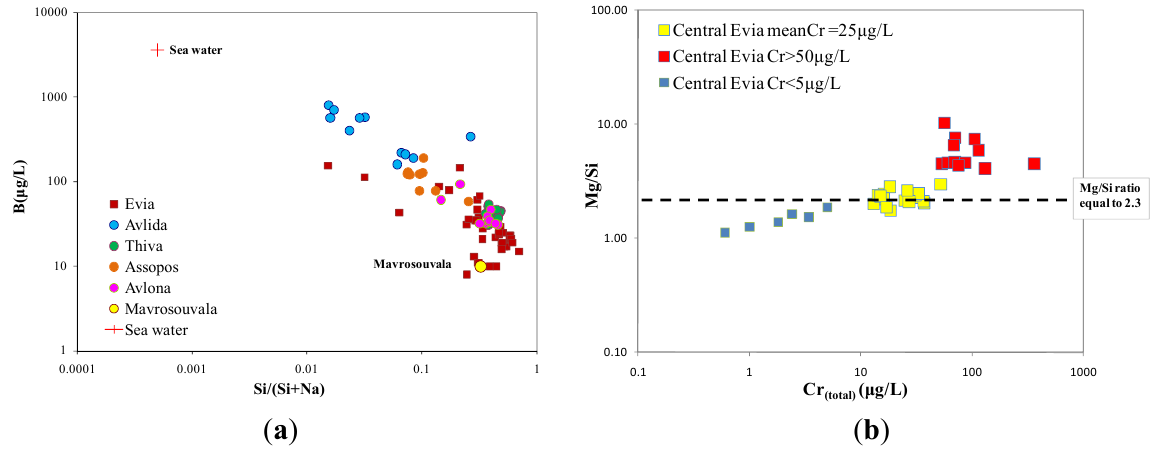
Figure 6. Variation of ( a ) B versus Si/(Si + Na); ( b ) Mg/Si versus Cr; ( c ) Mg/Si versus Ca/Si, and a plot of well depth versus Cr concentration, from the Assopos-Thiva basins and Central Evia. Data from